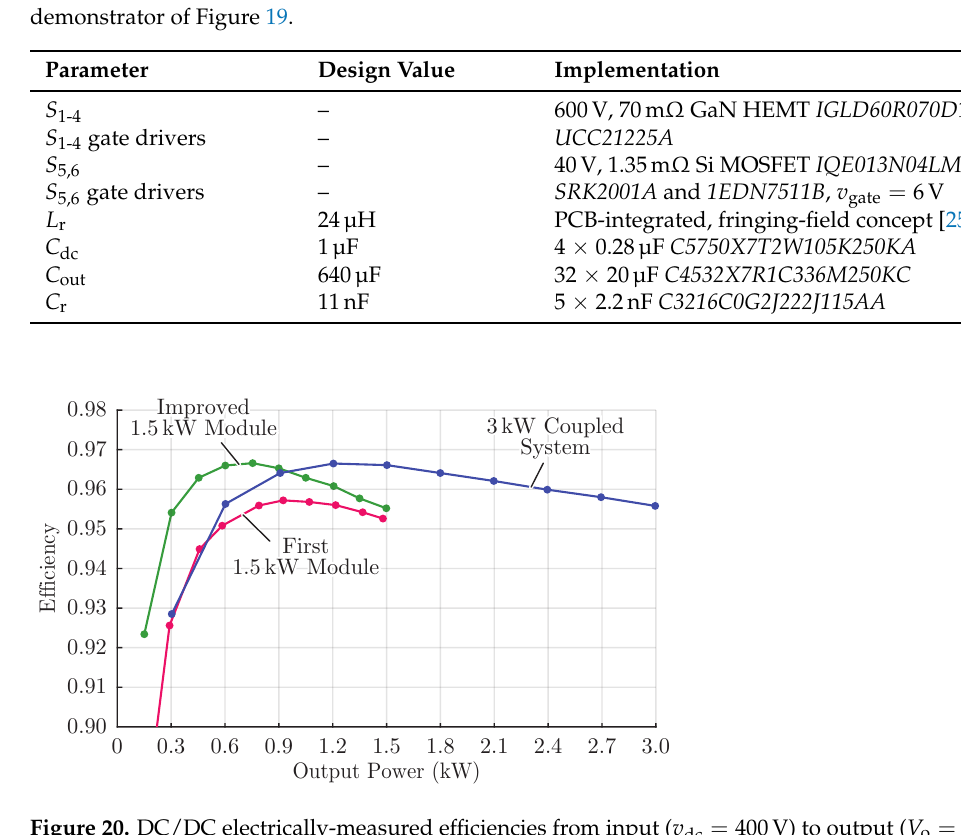
Figure 20. DC/DC electrically-measured efficiencies from input ( v dc = 400V) to output ( V o = 12V) at different load conditions, including all loss components. The improved DC/DC module achieves higher efficiency than the original module at all load conditions, and the paralleled 3kW converter achieves higher efficiency from reduced core losses at power levels below